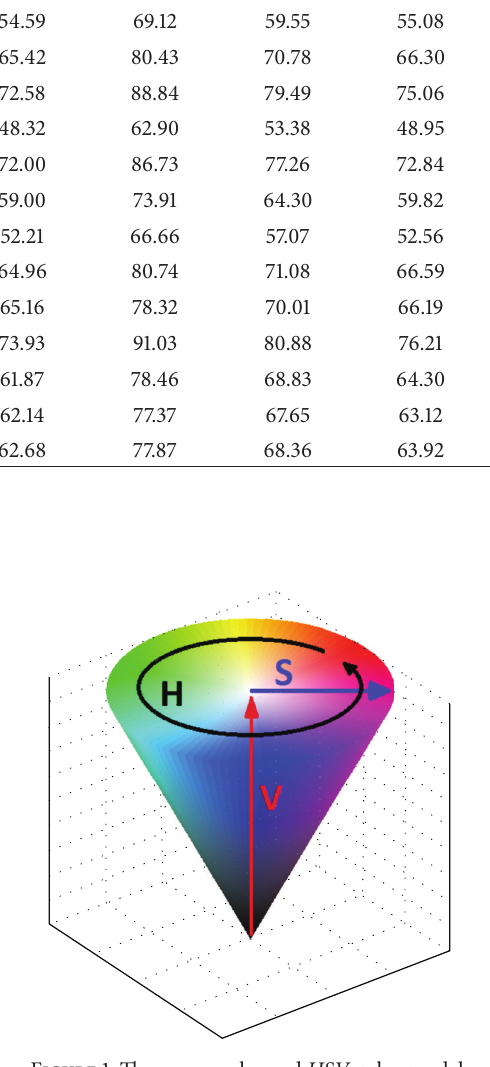
Figure 1: The commonly used HSV color